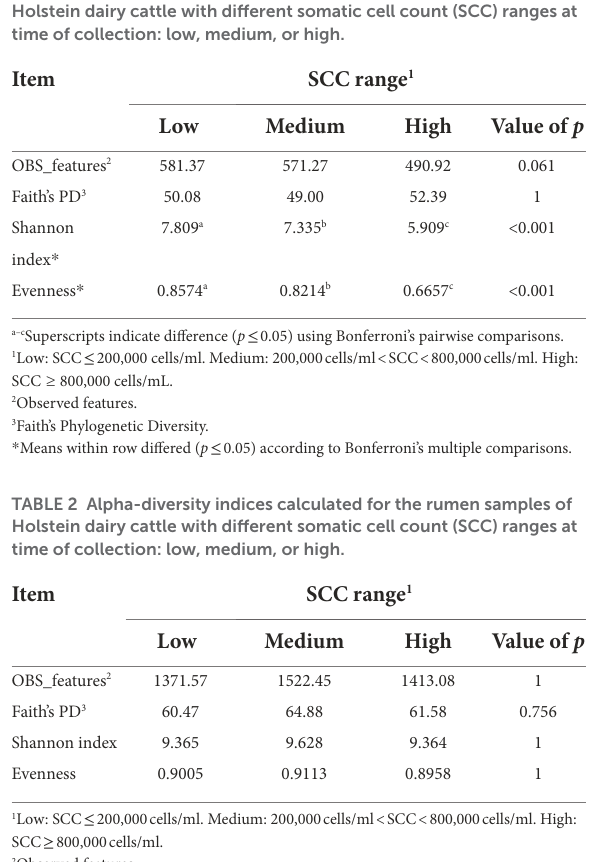
TABLE 1 Alpha-diversity indices calculated for the milk samples of Holstein dairy cattle with different somatic cell count (SCC) ranges at time of collection: low, medium, or high.